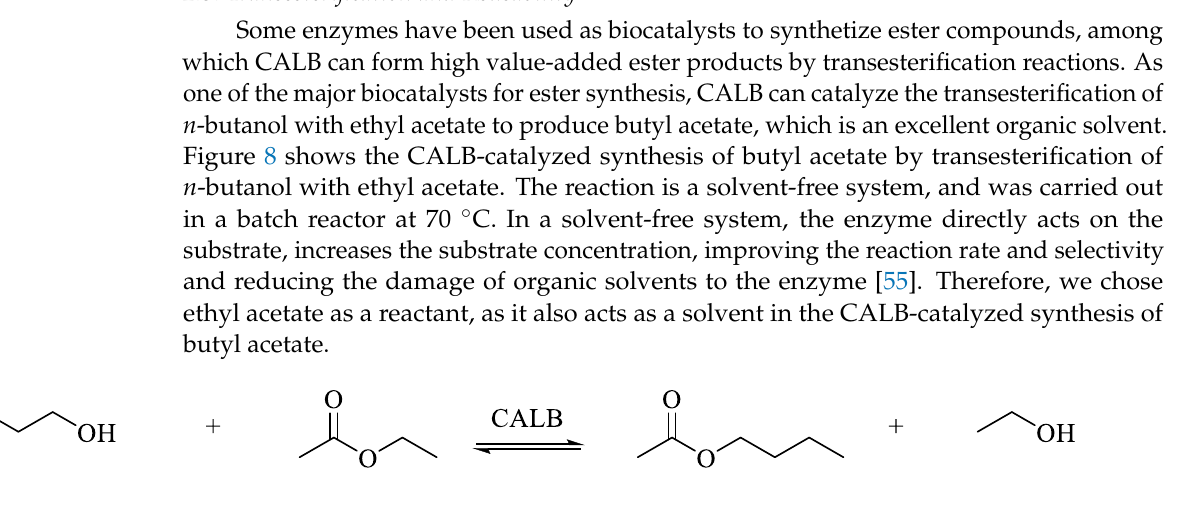
Figure 9. Conversion of n -butanol and repeatability of SiO 2 –CH 3 –CALB and SiO 2 –CH 3 – CALB@PDA. 2.6. Comparison of Butyl Acetate Production Using Previous Lipase Biocatalysts The prepared catalyst of SiO 2 –CH 3 –CALB@PDA possessed the advantages of bio- compatibility, environmental friendliness, operating convenience and safety. Compared with previous lipase catalysts, such as SiO 2 –CH 3 –CALB and Novozyme 435, the catalytic efficiency of SiO 2 –CH 3 –CALB@PDA (57.67%) in the transesterification reaction system was slightly higher than those of SiO 2 –CH 3 –CALB (52.42%) and Novozyme 435 (55.30%) [60]. Although the improvement in operational stability and catalytic performance is not obvious, the polydopamine modification strategy is worth adopting; it can improve the immobilized enzyme loading and balance the mechanical properties of the supports, which expands the application range of immobilized enzymes in some special cases. 3. Experimental Section 3.1. Materials Tetramethoxysilane (TMOS), methyltrimethoxysilane (MTMS), methanol (MeOH), sodium fluoride (NaF), polyethylene glycol (PEG, MW 400), dopamine hydrochloride, 4- nitrophenyl palmitate ( P -NPP), Coomassie Brilliant Blue G250, bovine serum albumin (≥96%), n -butanol, ethyl acetate, n -propanol and sodium-phosphate buffer (PBS, 0.1 M, pH 7.5) were purchased from Aladdin (Shanghai, China). Candida Antarctica lipase B (CALB) was provided from Novozymes (Copenhagen, Denmark) with a free enzyme ac- tivity of 510 U·g −1 . All reagents except bovine serum albumin were analytically pure with- out further purification.